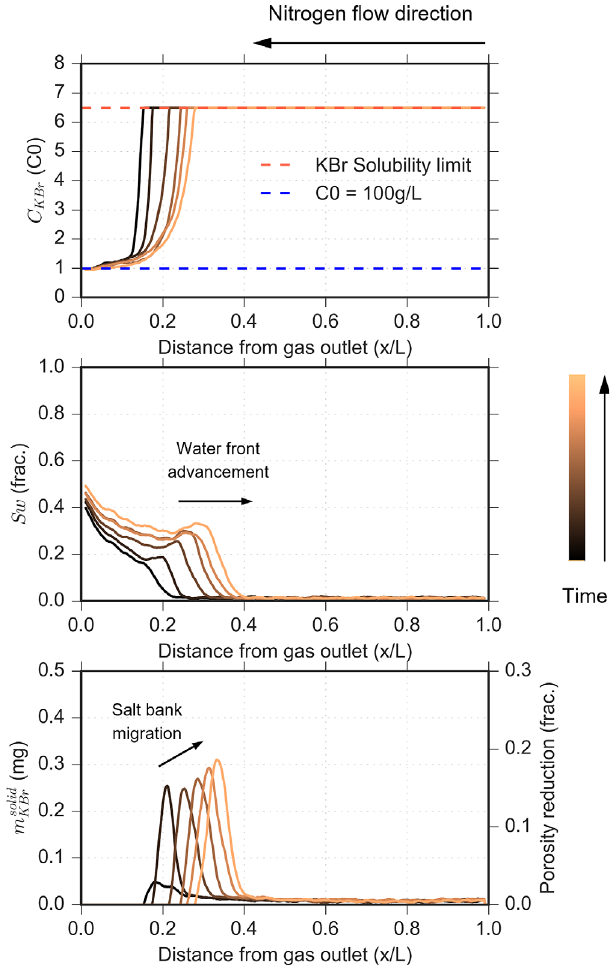
Fig. 10. Brine concentration C KBR , brine saturation Sw and precipitated salt pro fi les m solid pro fi les computed during the salt KBr accumulation. The reduction of porosity is estimated from the m solid curves. Pro fi les are computed regularly from t = 100 min to KBr t = 150 min. The mass of salt is given for a pixel volume of 6.67 (cid:1) 10 (cid:3) 4 cc.